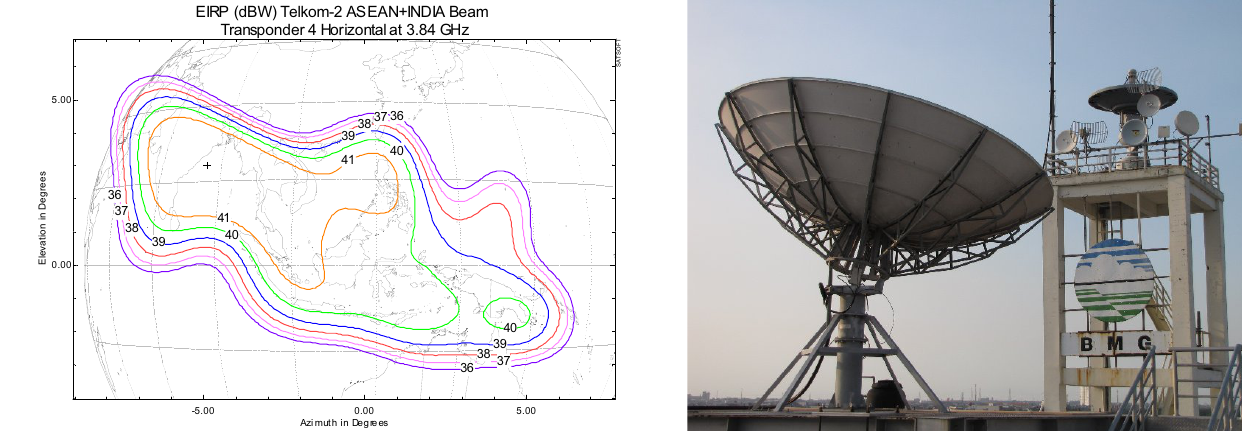
Fig. 9. 4.5m antenna for the VSAT hub system in Jakarta since 2007.